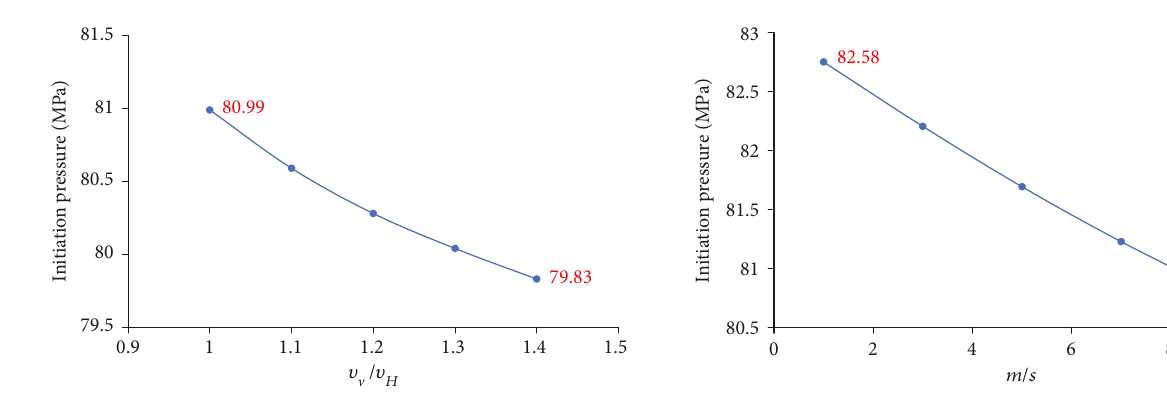
Figure 13: The relationship curve between initiation pressure and m / s .